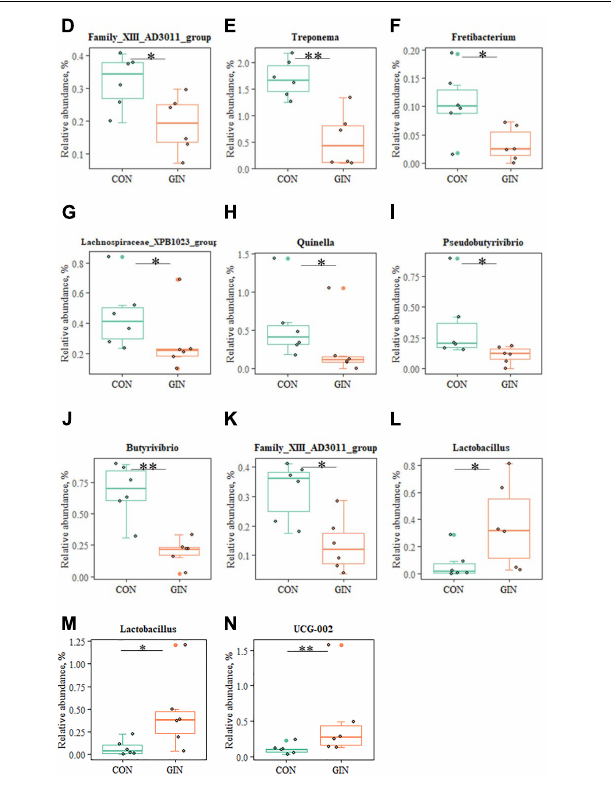
FIGURE 6 | The top 10 genus and significant different genus of rumen, abomasum and duodenum. (A–C) The top 10 genus of rumen, abomasum and duodenum; (D) significantly different genus in rumen; (E–L) significantly different genus in abomasum; (M,N) significantly different genus in duodenum. ∗ P < 0.05, ∗∗ P <